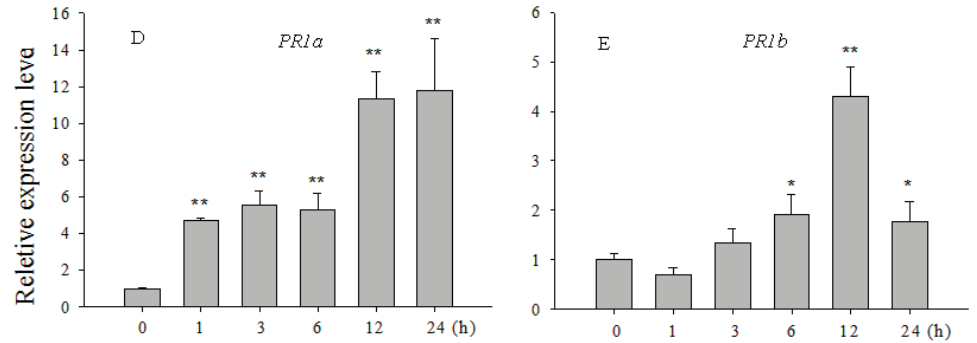
Figure 2. Quantitative PCR analysis of relative OsCBSX3 transcript levels in rice plants exposed to pathogens and exogenous hormones.( A ) OsCBSX3 transcripts tested at different time points in the rice leaves after inoculation with M. oryzae strain guy11; ( B – E ) OsCBSX3 transcripts examined in rice leaves at various time periods after treatment with salicylic acid (SA) (100 μ M) or methyl jasmonate (MeJA) (100 μ M). OsPR1a or OsPR1b genes were used as positive controls, respectively. ( A – E ) Transcript levels of OsCBSX3 or marker genes in pathogen- or hormone-treated rice plants were normalized to those in mock-treated control plants, which were set to a relative expression level of “1”. Error bars indicate the standard error; the experiments were repeated three times along with at least three independent repetitions of the biological experiments. Asterisks indicate significant differences (Student–Newman–Keuls test, * p < 0.05 or ** p < 0.01).